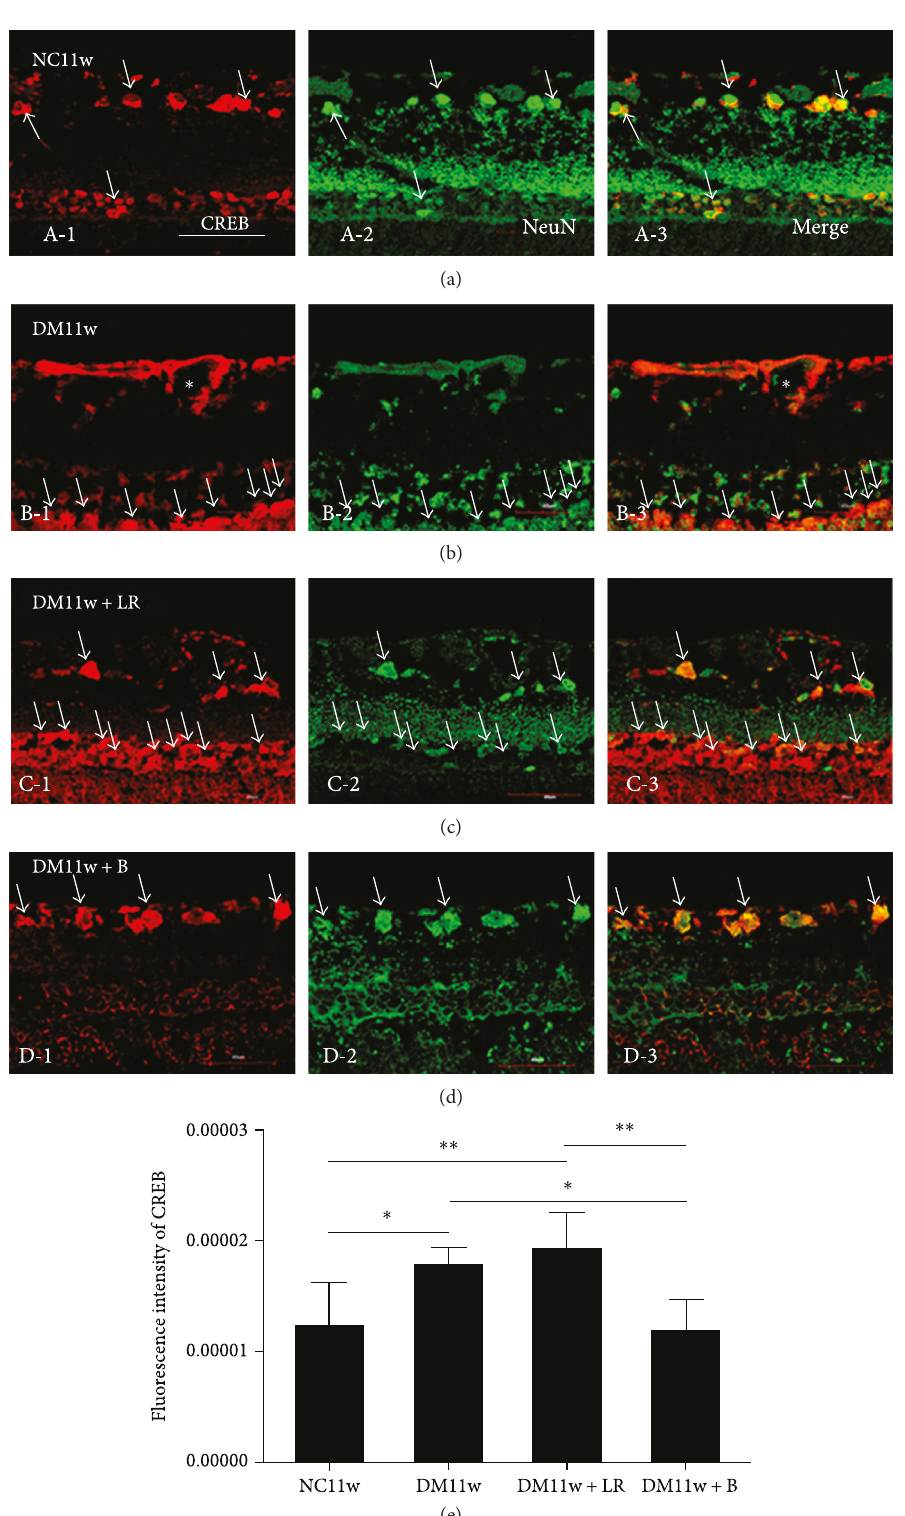
Figure 9: Representative photomicrographs of CREB (red) and NeuN (green) double staining of the retina in the NC11w, DM11w, DM11w +LR, and DM11w+B groups. CREB immunoreactivity is localized in NeuN-labeled neurons (single arrow) and blood vessels (asterisk). (b, C-1) In the DM11w and DM11w+LR groups, CREB expression was notably increased and even could be found in IPL. (D-1) However, CREB almost expressed only in GCL in the DM11w+B group. (e) Semiquanti fi cation of CREB by immuno fl uorescence. Bar=50 μ m. ∗ p < 0 05 and ∗∗ p < 0 01